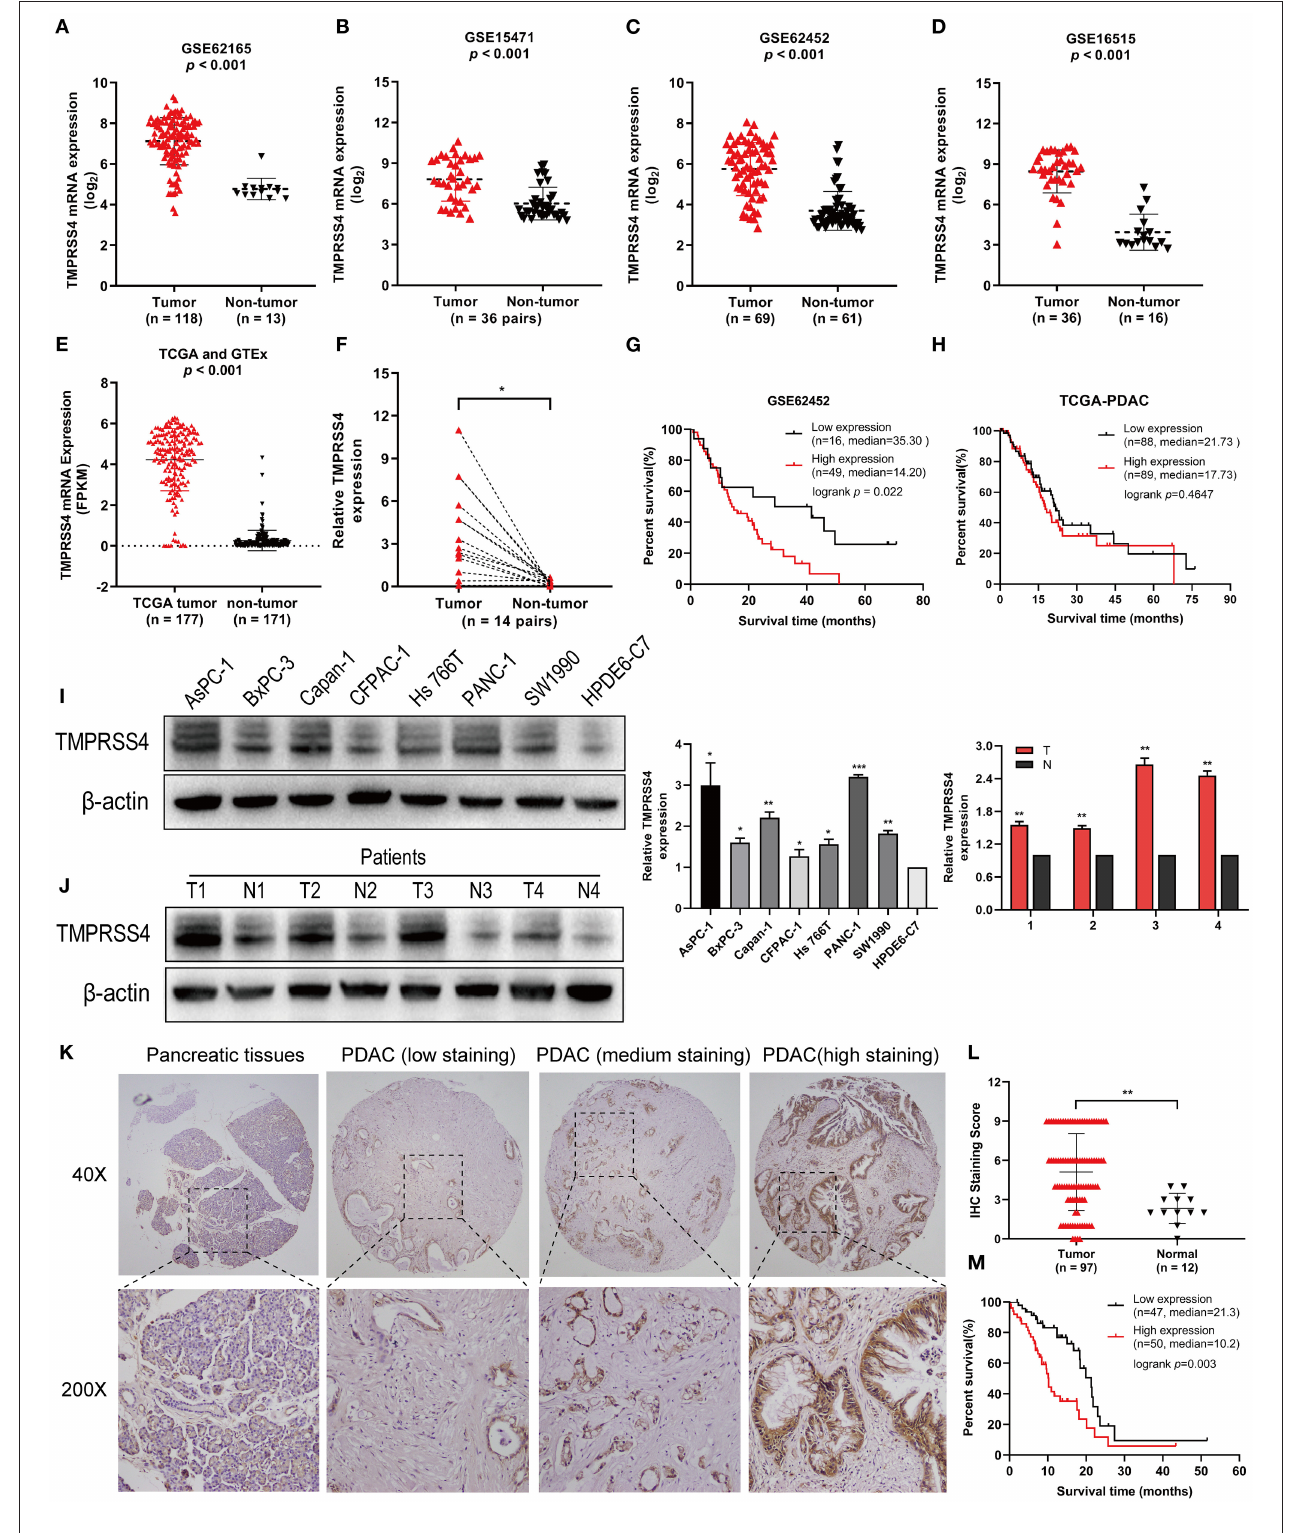
FIGURE 1 | TMPRSS4 is overexpressed in PDAC and associated with poor prognosis. (A–E) The mRNAs expression profile showed TMPRSS4 overexpression in pancreatic cancer tissue as compared to non-tumor tissue obtained from the public database (GSE62165, GSE15471, GSE62452, GSE16515, TCGA, and